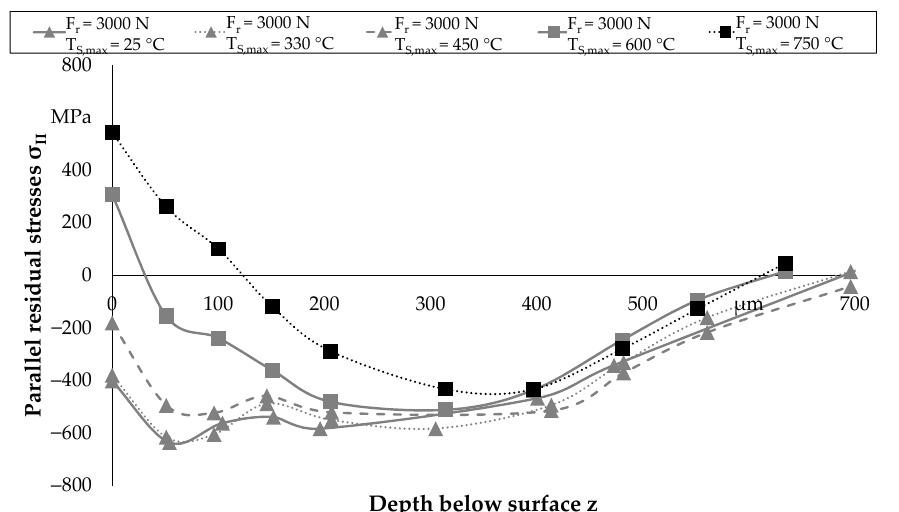
Figure 5. residual stress depth distribution parallel to the rolling direction for T S,max = 25 °C, 330 °C, 450 °C, 600 °C and 750 °C with the deep rolling force F r = 3000 N.